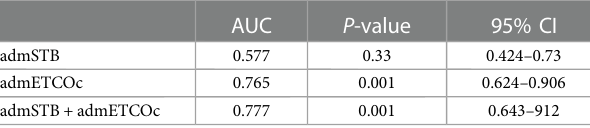
TABLE 3 AUC of ETCOc, STB, and the combination of